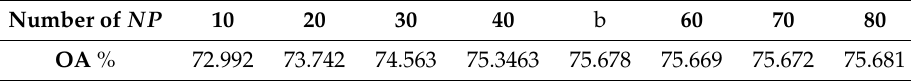
Table 2. The OA values obtained by the proposed algorithm with different NP